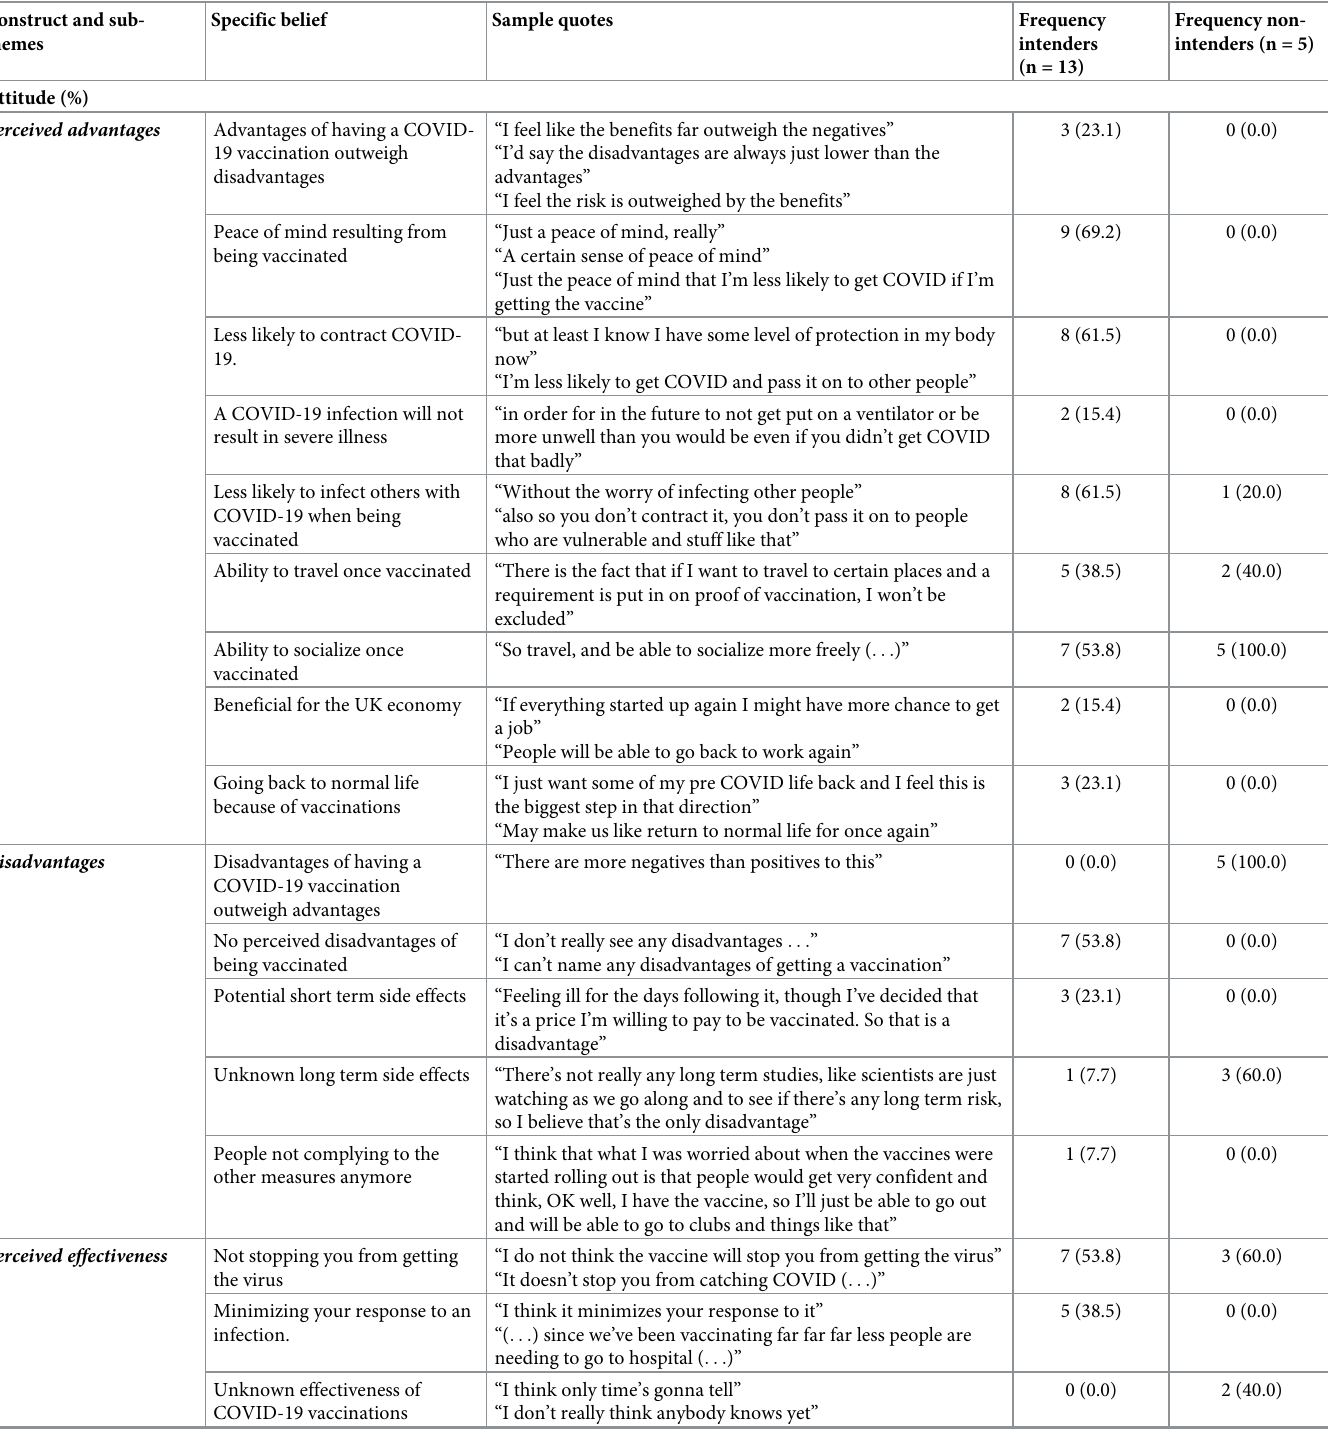
Table 3. Motivation phase beliefs. Construct and sub-